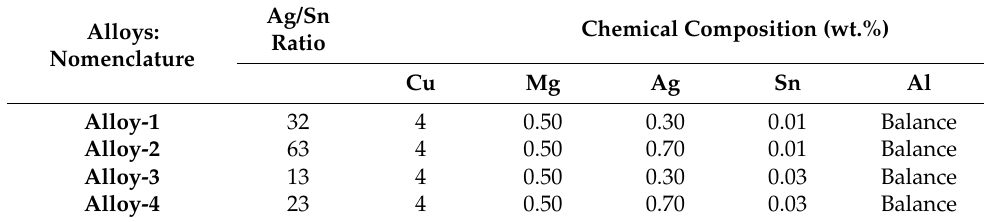
Table 1. Results of the chemical composition and Ag/Sn ratio of the experimental alloys.